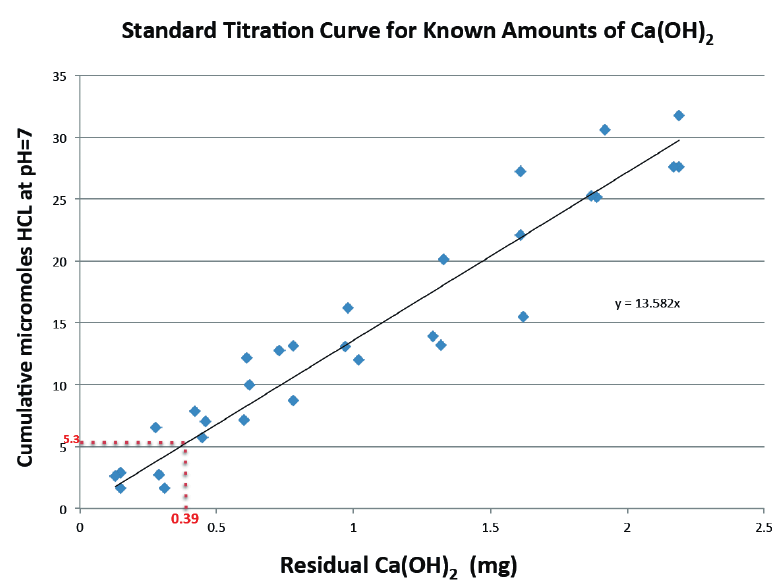
Figure 2- Sample standard curve. Cumulative µmoles of HCL at pH=7 for each standard was plotted against initial known weights (mg) of Ca(OH) . For example, the vertical red dotted line indicates that 0.39 mg of Ca(OH) 2 5.3 µmoles of HCL to reach pH=7.0 (horizontal red dotted line). Using these standard known amounts, we can create a linear regression line to determine the amounts of Ca(OH) in our unknown samples by the µmoles of HCL used to get to 2